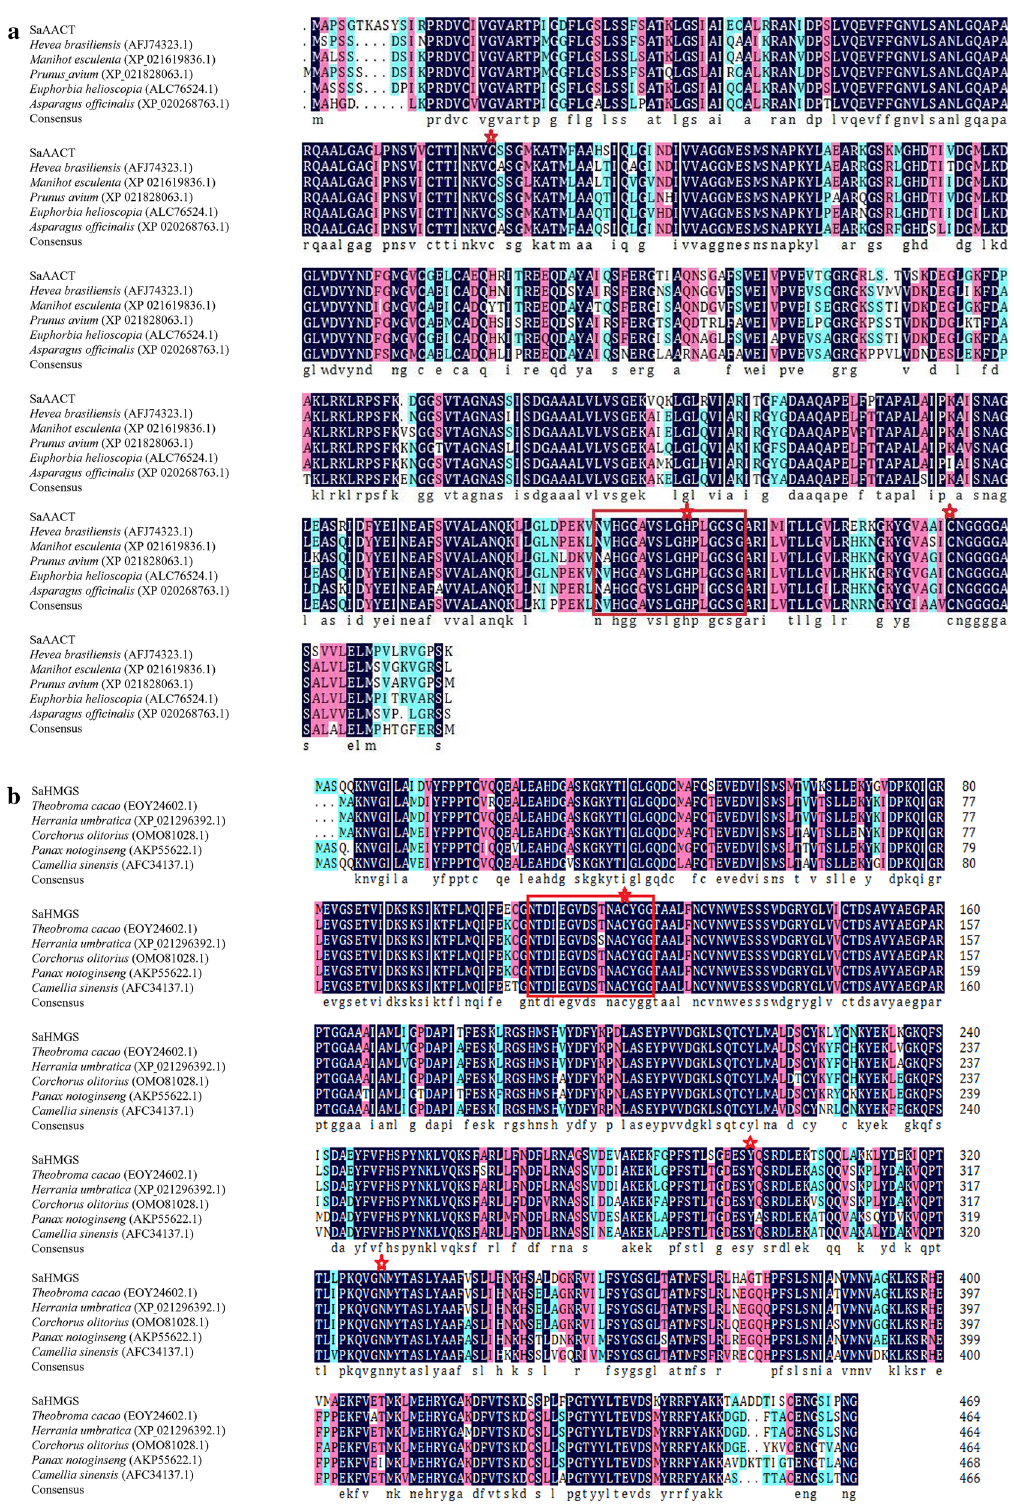
Figure 3. Multiple alignments of SaAACT ( a ) and SaHMGS ( b ) deduced amino acid sequences with other corresponding homologous proteins. The figures were a comparison diagram and cluster analysis of my own gene sequences with related sequences of other species by CLUSTALX 2.0 and